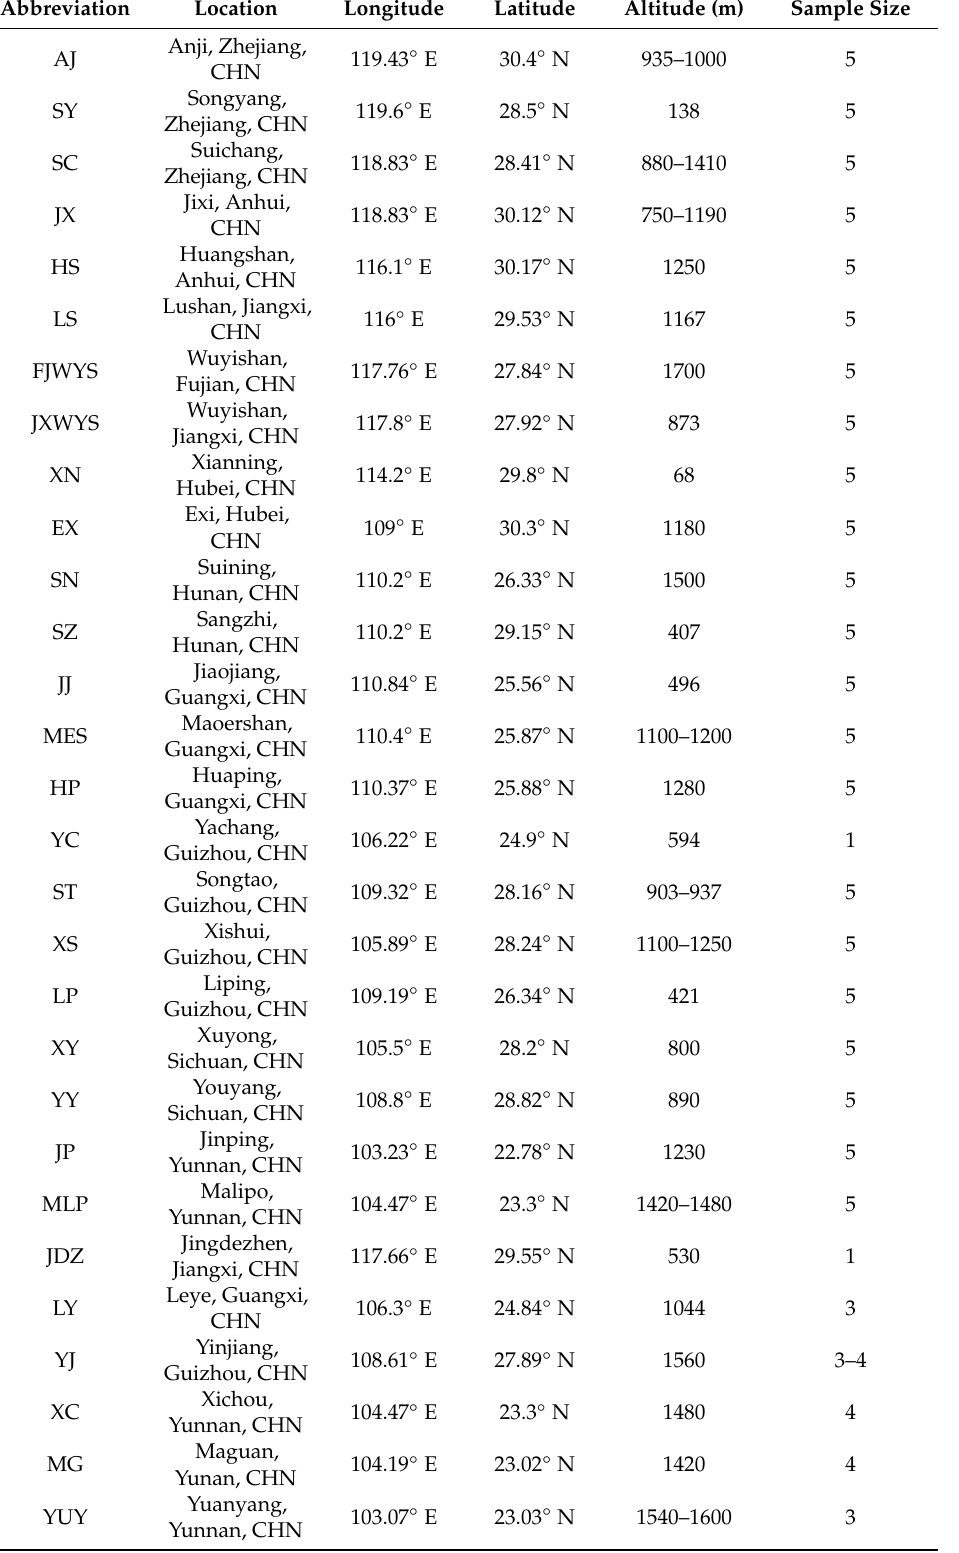
Table 1. The sample size, location, abbreviated name, altitude, and geographical coordinates of the sampled L. chinense